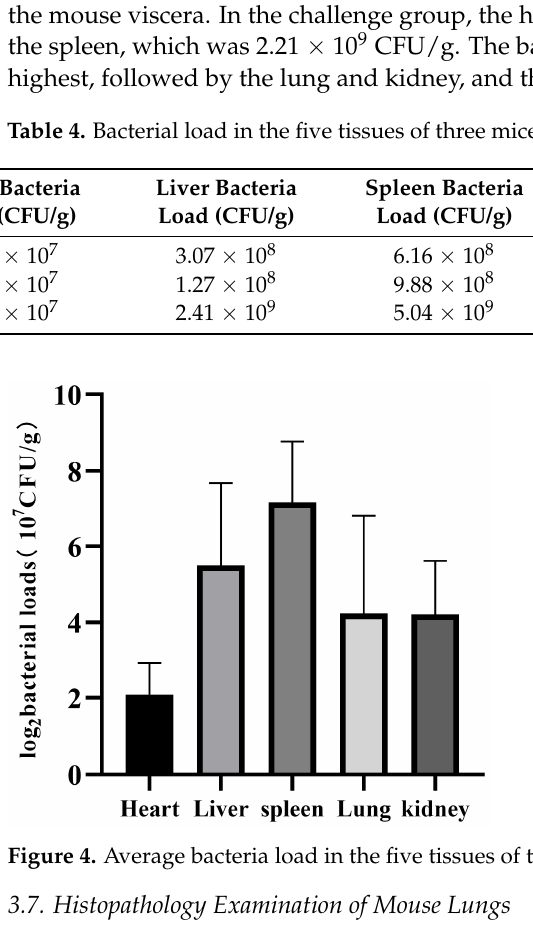
Figure 4. Average bacteria load in the five tissues of three mice.